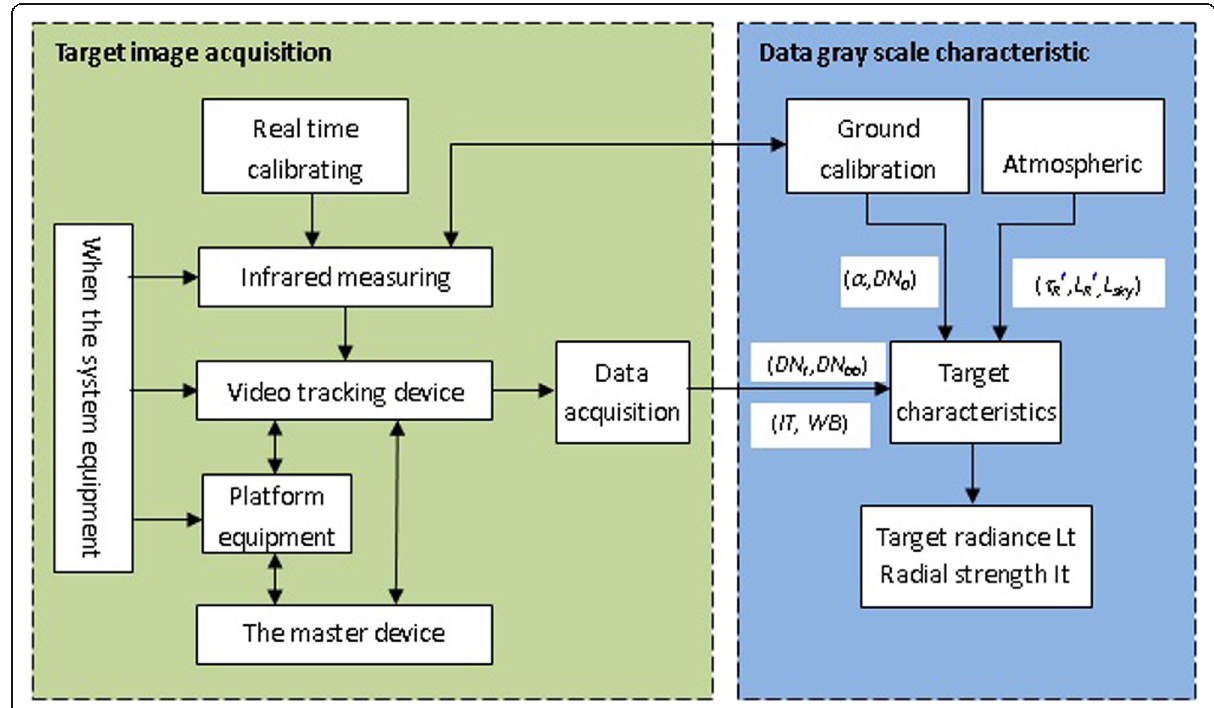
Fig. 1 Schematic diagram of the model